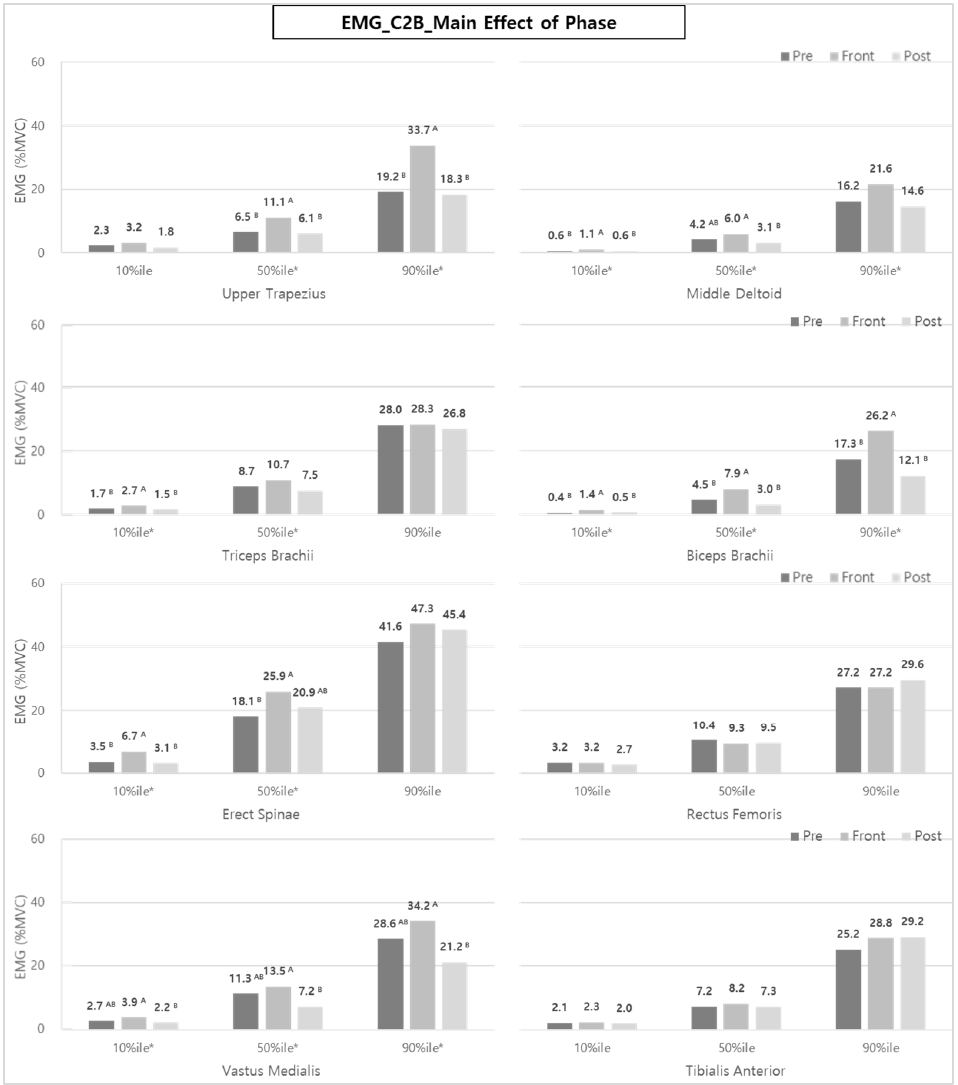
Figure 10. The effect of phases on each muscle activity during C2B. Asterisk (*) and the alphabet capital letter (A and B) indicate that the difference between means is statistically significant at p <